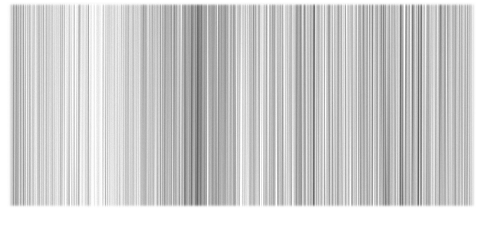
Figure 11. Example of slow-motion image